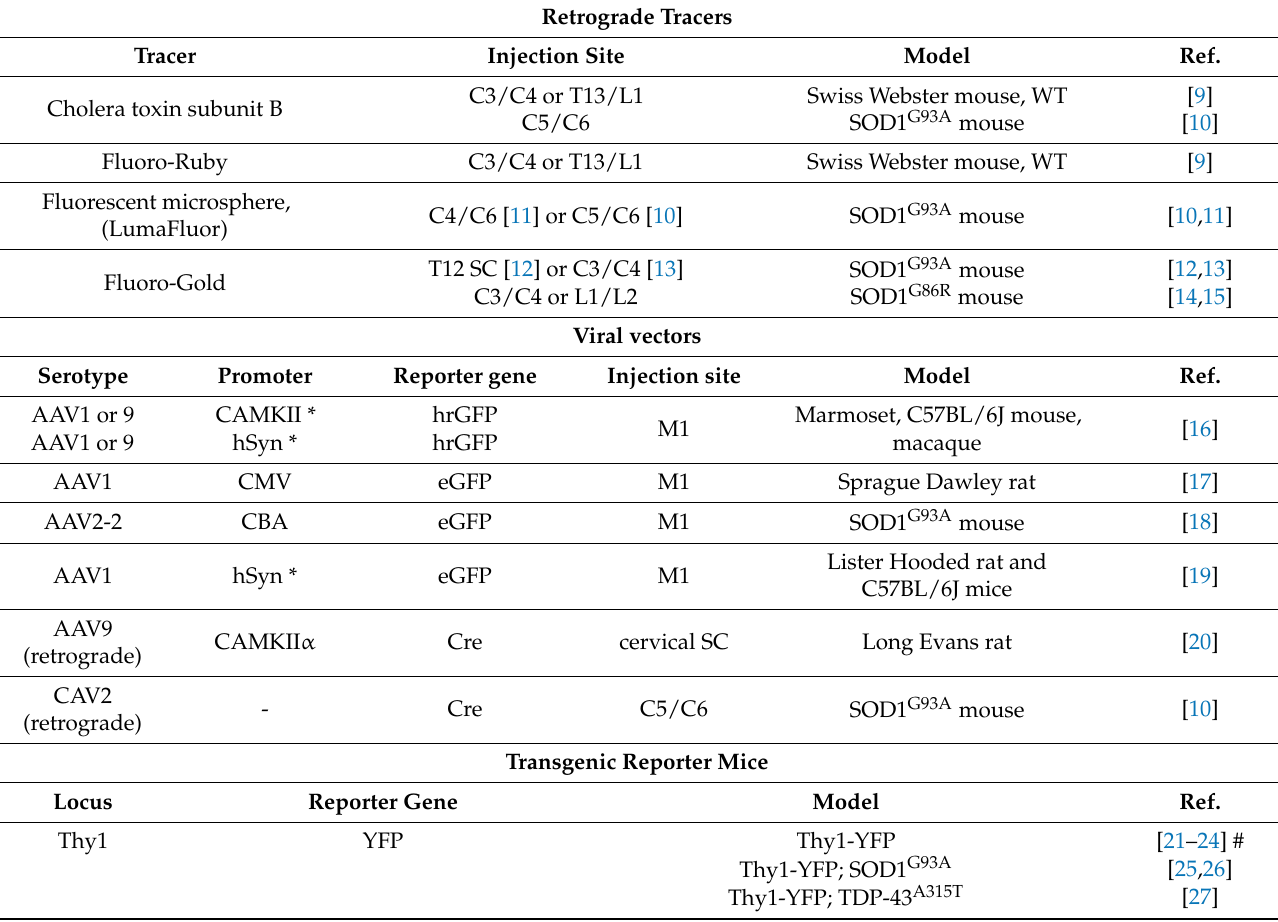
Table 1. Gene delivery methods to selectively label and visualize UMNs in